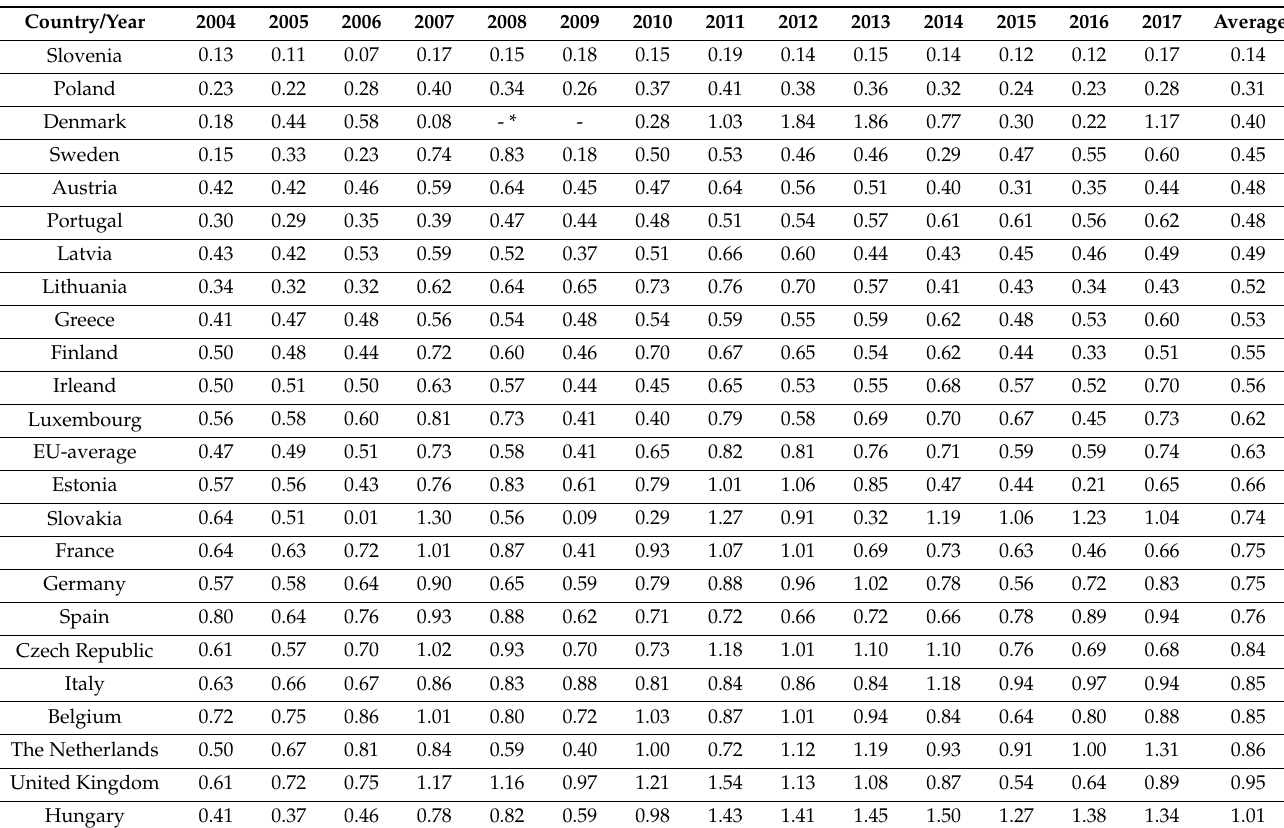
Table A1. Ratio of family farm income per family full-time employee (Family Farm Income/FWU) to non-agricultural income in EU countries in 2004–2017.